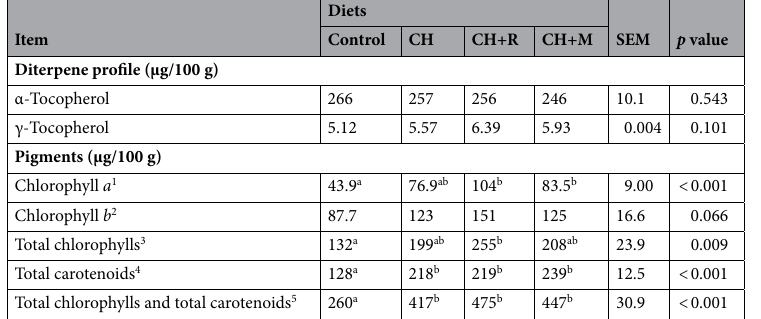
Table 3. Influence of experimental diets on diterpene profile and pigments in the liver of piglets. Dietary treatments: Control—control diet; CH—5% Chlorella vulgaris diet; CH+R—5% Chlorella vulgaris diet supplemented with 0.005% Rovabio Excel AP; CH+M—5% Chlorella vulgaris diet supplemented with 0.01% enzymatic mixture. 1 C a = 11.24 A662 − 2.04 A645. 2 C b = 20.13 A645 − 4.19 A662. 3 C a + b = 7.05 A662 + 18.09 superscripts differ significantly at p < 0.05.